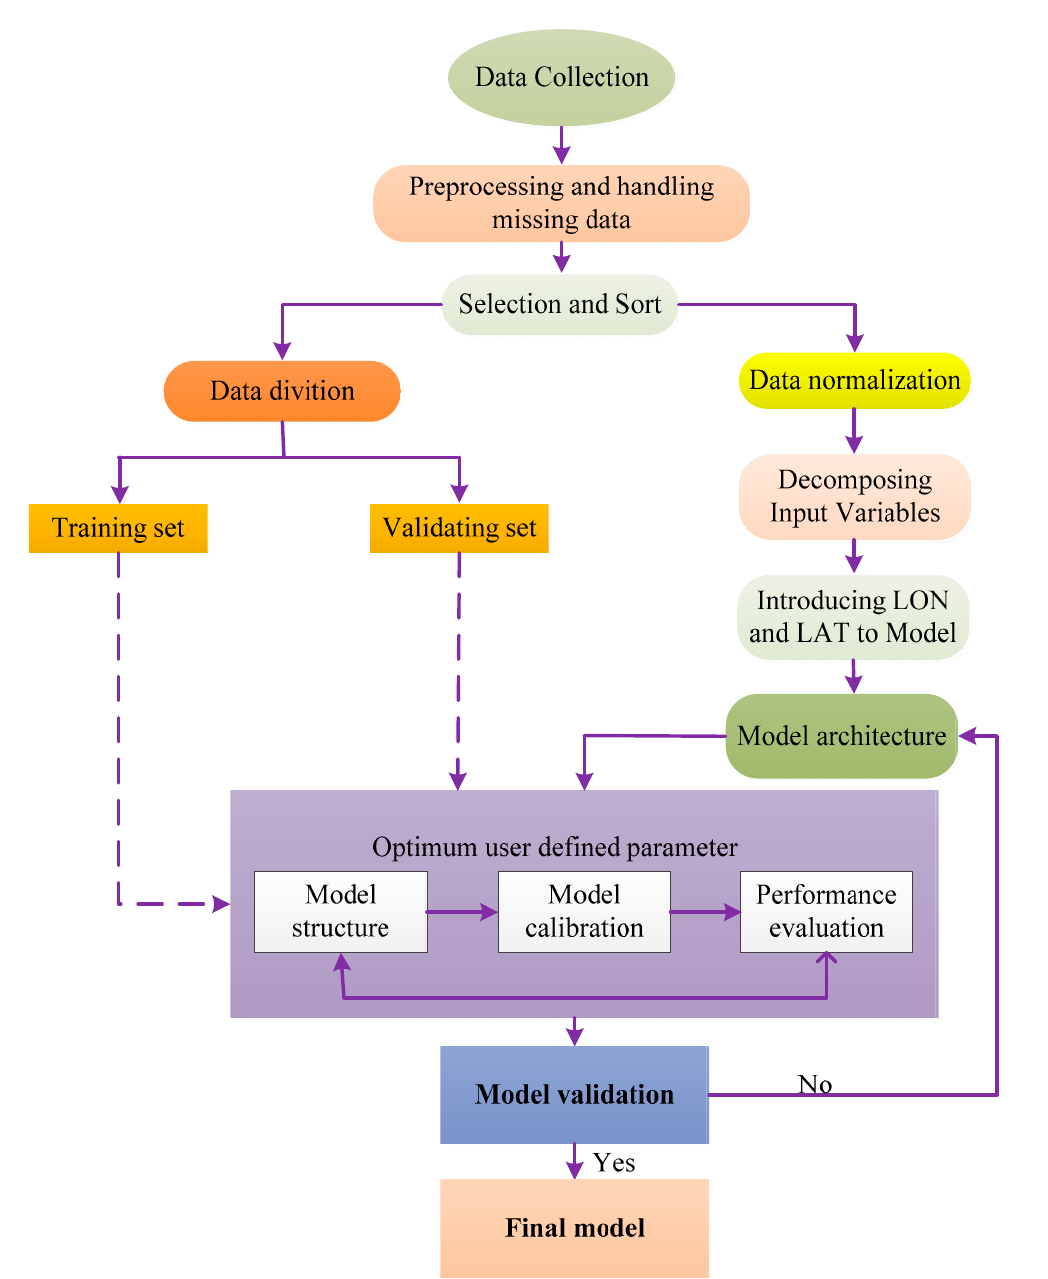
Figure 1. The framework of the approach used in the